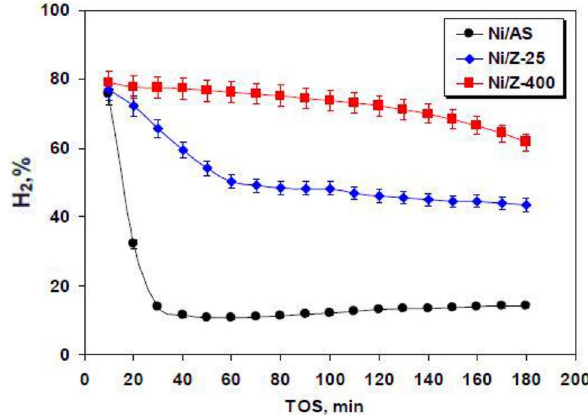
Fig. 3 Comparison of different silica materials as a catalyst support in terms of hydrogen yield from methane decomposition